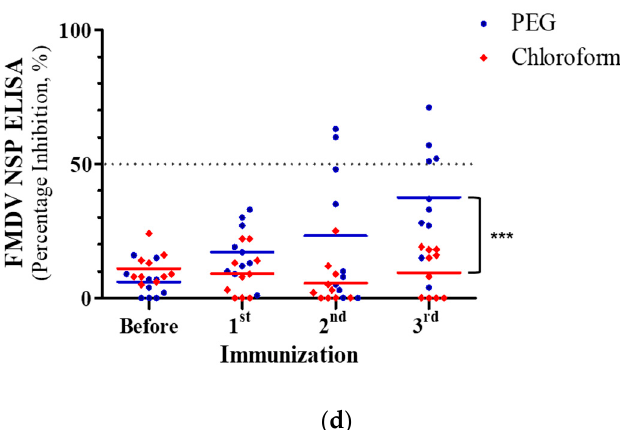
Figure 3. Antibody responses elicited by immunizations with PEG and chloroform treated FMD vaccines. ( a ) Scheme of animal experiment. Goats were divided into 2 groups and vaccinated three times at a 4-week interval with PEG ( n = 10) and chloroform ( n = 10) treated FMD vaccines. Blood samples were collected every 4 weeks after vaccination. ( b ) Antibody titers of structural protein were measured by ELISA. The antibody values were expressed as percentage inhibition (PI). PI value of ≥ 50% (dotted line) was considered positive. ( c ) Homologous virus-neutralizing (VN) antibody titers were measured by virus neutralization test. The VN titers were expressed as a log 10 value. A titer of ≥ 1.653 log 10 (dotted line) was considered positive. ( d ) Antibody titers of non-structural protein were measured by ELISA. The antibody values were expressed as PI. PI value of ≥ 50% (dotted line) was considered positive. The full blue and red lines represent the mean of the PI values in each group. A statistically significant difference of the mean values between the two groups in the third vaccination was indicated. *** p < 0.001.